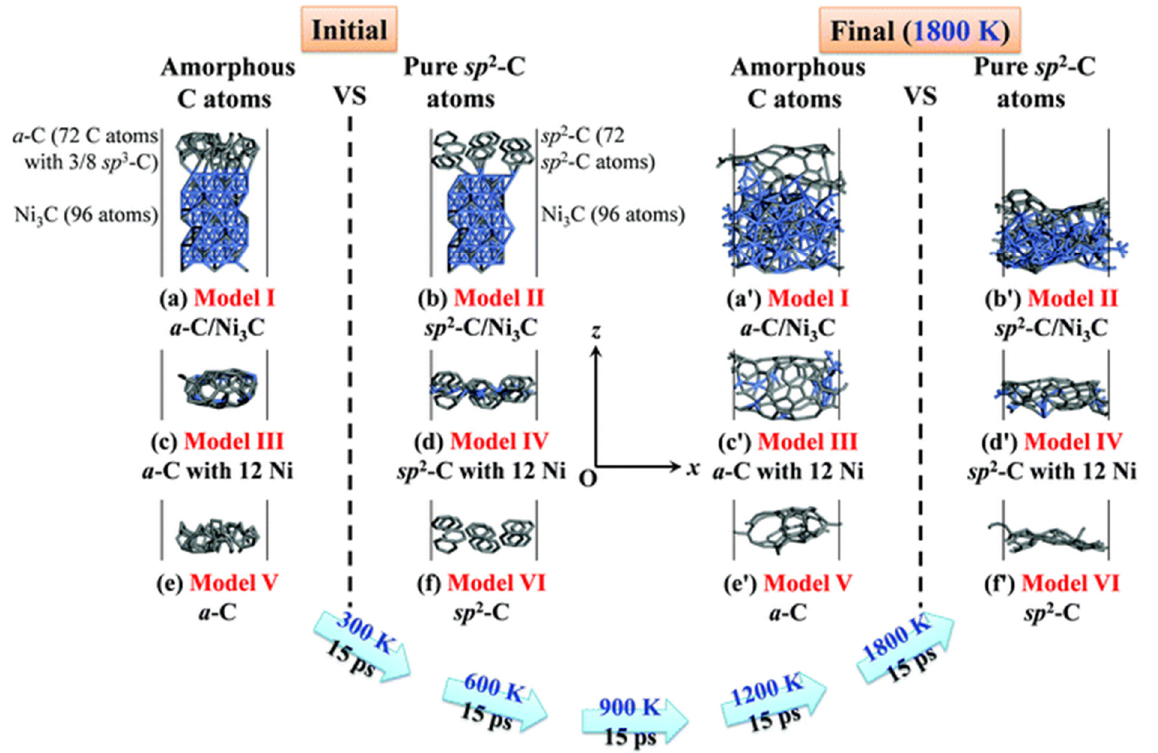
Figure 2. The conversion from an initial configuration ( a -C/Ni 3 C, a -C with 12 Ni, a -C, sp 2 -C/Ni 3 C, sp 2 -C with 12 Ni, and sp 2 -C) to a final model with different initial temperature [73] . Copyright 2016, Royal Society of Chemistry.